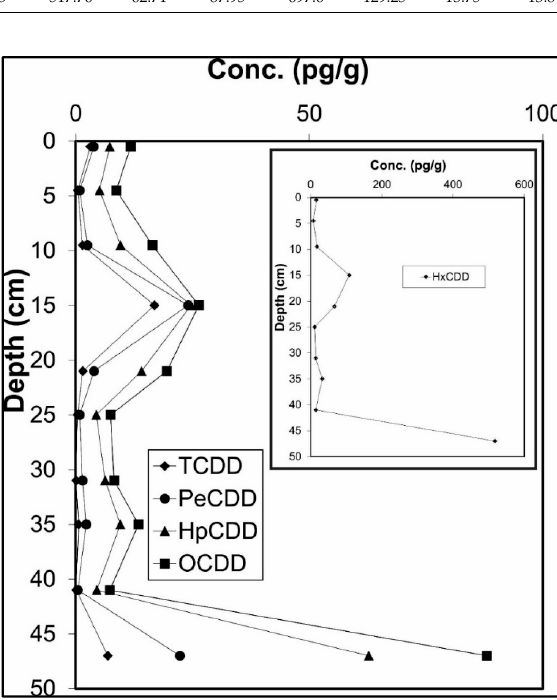
Figure 7. Downcore variation in dioxin homologue concentration for bulk sediment samples. Inset shows HxCDD, which is present at significantly higher concentrations than the other homologues.